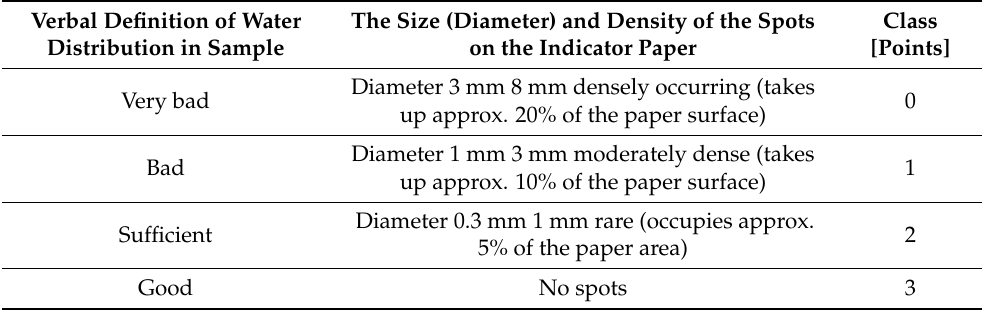
Table 2. Classification of butter and butter substitutes according to the degree of water distribution [32,34]. Verbal Definition of